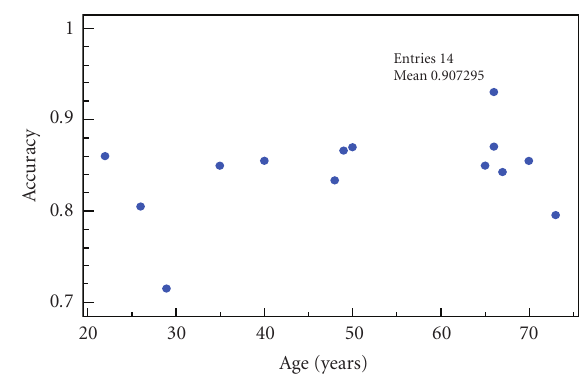
Figure 5: Variation of accuracy with the subjects’ age.